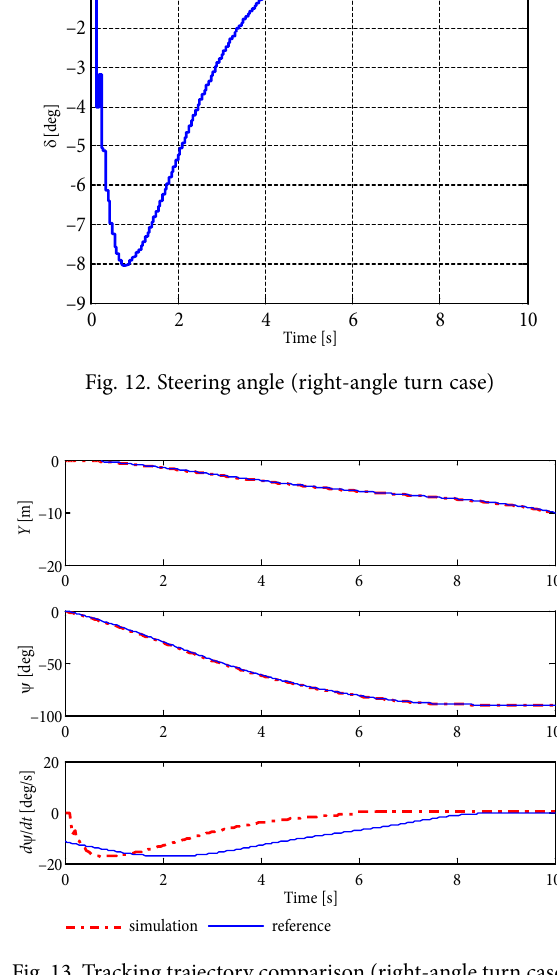
Fig. 10. Wheel slip ratios (lane-change case)